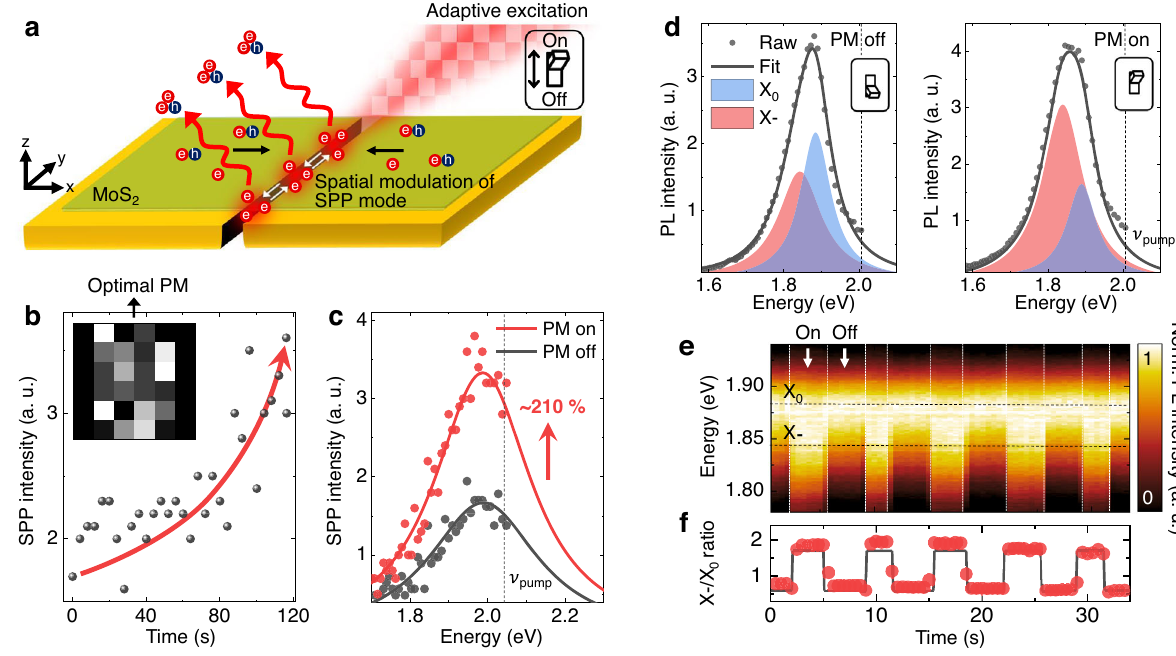
Fig. 4 | All-optical control of exciton – trion interconversion. a Illustration of spatio-spectral modulation of SPP mode and excitonic emission response through adaptivewavefrontshaping. b EvolutionofSPPintensityduringstepwisesequence feedback.Inset:optimizedphasemask(PM)aftersequencefeedback. c SPPspectra before (black) and after (red) wavefront shaping. d Corresponding PL spectra